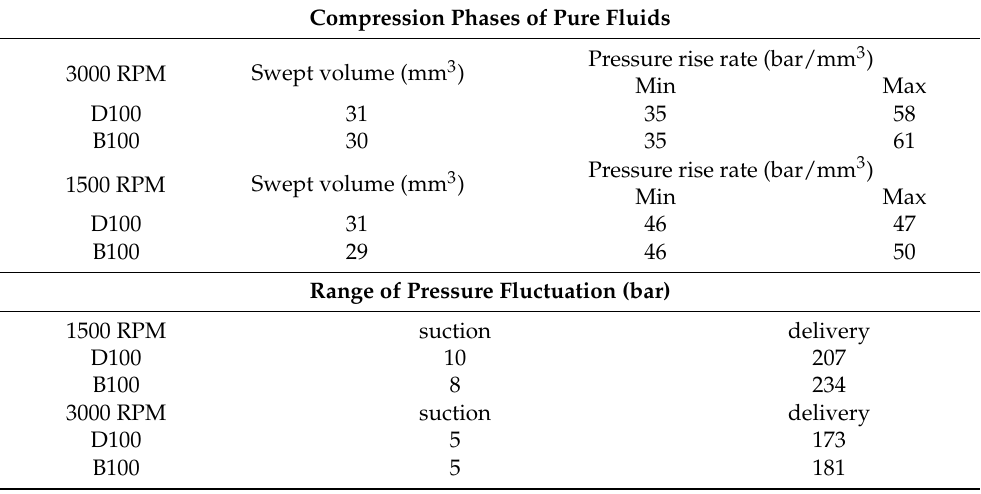
Figure 12. PWC, rail, and inlet diagrams for B100 and D100 at 1500 RPM, HP. Table 7. Pump response to pure fluids.